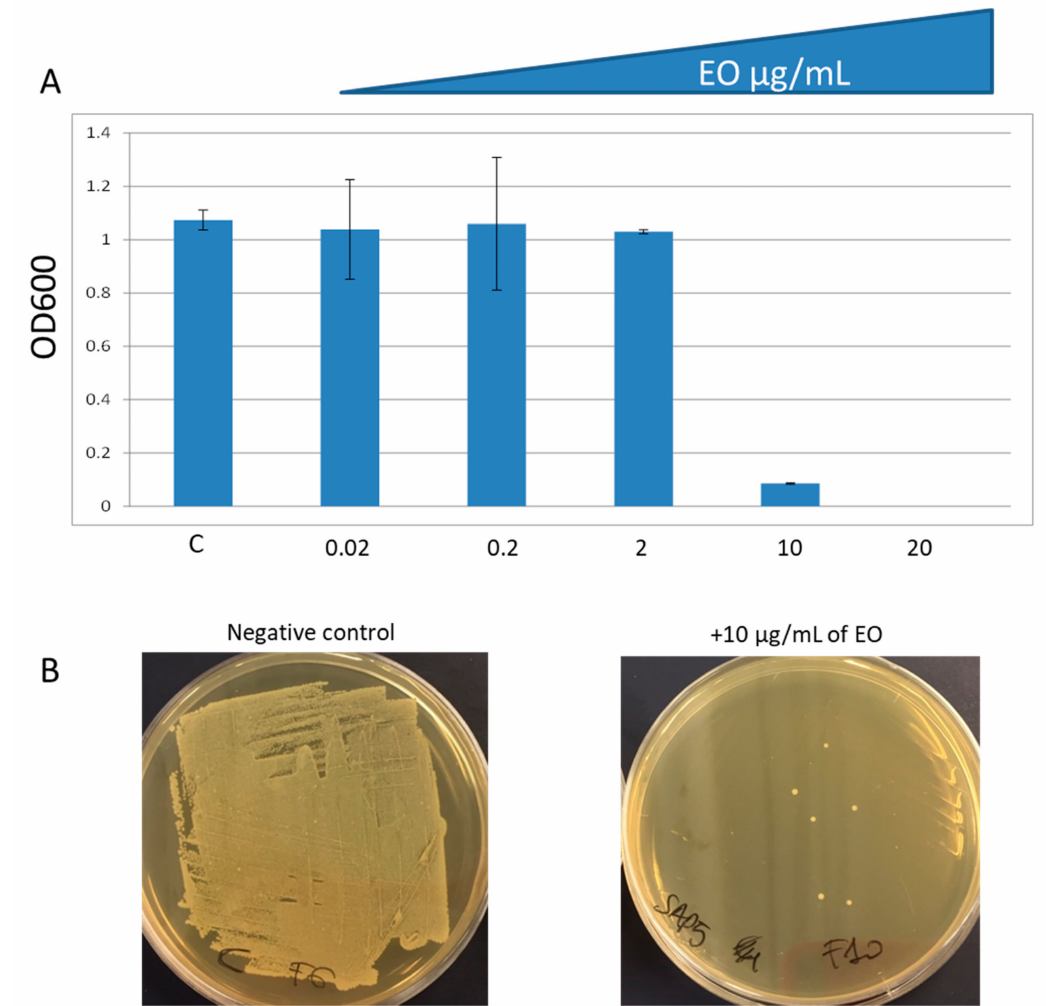
Figure 5. E ff ect of EO on S. aureus ATCC25923 growth. A : determination of total bacterial count. Data are average from triplicate experiments. Bars represent standard deviations of triplicate incubations. B : determination of vital bacterial count when 10 µ g / mL of EO were added. Negative control represents the bacterial culture incubated with DMSO.